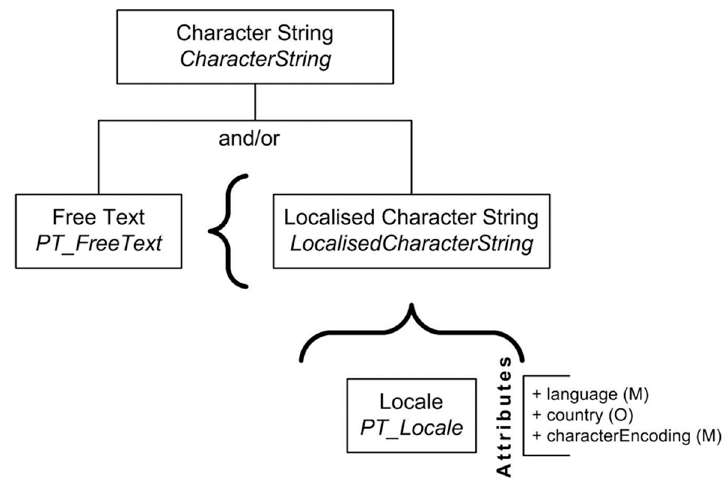
Figure 11. NAP-Metadata capabilities for handling multiple languages.